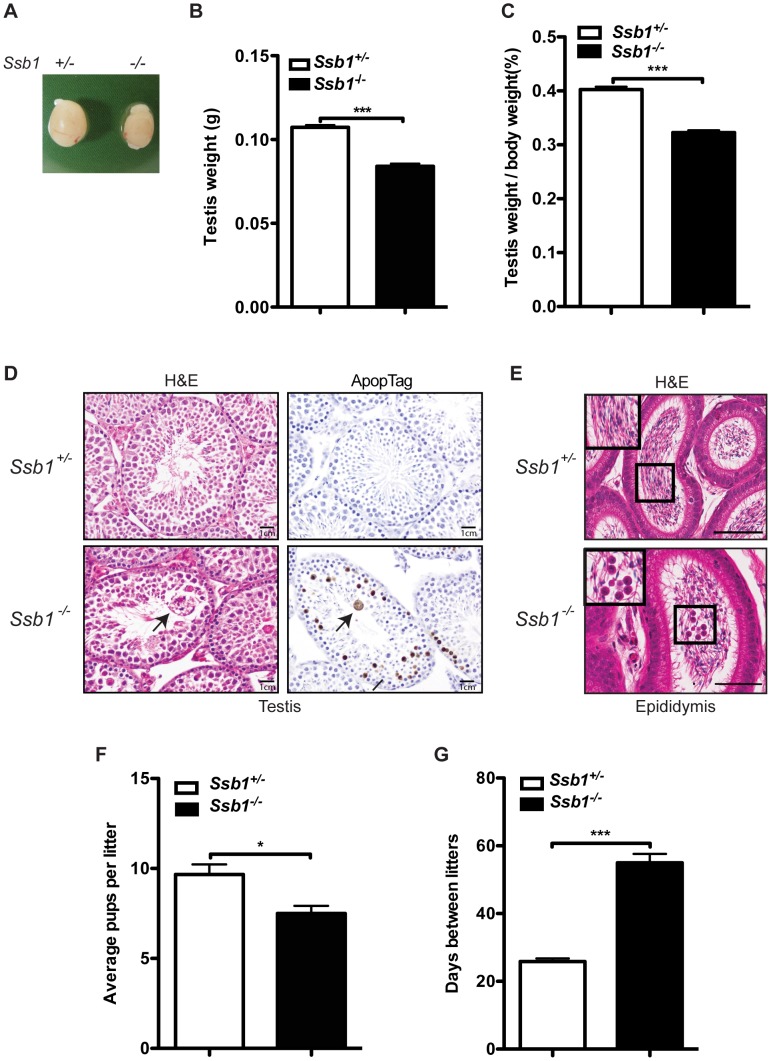
Testicular degeneration and impaired fertility in conditional Rosa26-CreERT2: Ssb1
−/− male mice.(A) Representative image of testes from Rosa26-CreERT2: Ssb1
−/− mice compared with those from Rosa26-CreERT2: Ssb1+/− littermates at 10 weeks of age. (B) Testis weight and (C) the gonado-somatic index (GSI) in conditional Ssb1 deleted male mice compared with their littermates. Data represents the mean ± SEM of testis weight (n = 8, ***P<0.001; student's t-test) and the GSI (C) from 8 mice in each group. (D) Representative images of testis sections stained with Haematoxylin and eosin (left panels) and ApopTag for the detection of apoptotic cells (right panels). Note the multinucleated giant cells (black arrow) frequently present in the lumen in the testes from Rosa26-CreERT2: Ssb1
−/− mice. Spermatogenic cells in Rosa26-CreERT2: Ssb1
−/− testes showed an elevated apoptotic marker (black arrows, lower panel, right, Scale = 25 µm). (E) Haematoxylin and eosin staining showing epididymides of Rosa26-CreERT2: Ssb1
−/− mice containing prematurely sloughed developing germ cells. The upper panel displays maturing spermatozoa in the wild type epididymis. In contrast, immature germ cells (black arrow) are present in the epididymis of Rosa26-CreERT2: Ssb1
−/− mice (lower panel). Embedded images in the left corners show magnified views of the selected areas (Scale = 50 µm). (F) Litter size from Rosa26-CreERT2: Ssb1
−/− male breeders (n = 4) with wild type female mice compared with those from Rosa26-CreERT2: Ssb1+/− breeders (n = 6, *P<0.05; student's t-test). (G) Litter interval in Rosa26-CreERT2: Ssb1
−/− male mice (average of 63 days, n = 4) and Rosa26-CreERT2: Ssb1+/− males (average of 27 days, n = 6, ***P<0.001; student's t-test).